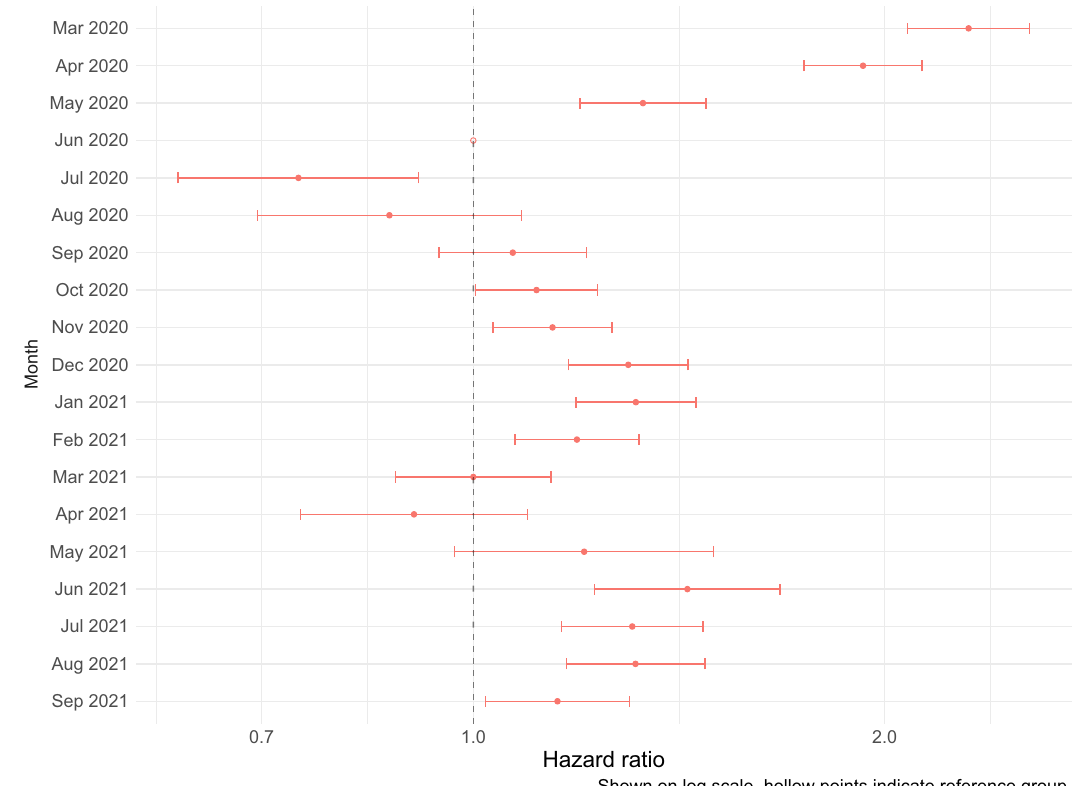
Hazard ratio Shown on log scale, hollow points indicate reference group. load, and CCI. Reference group: June 2020. n =238,897 individuals with necessary information reported. Figure shows point estimate of hazard ratio with 95% con- fi dence